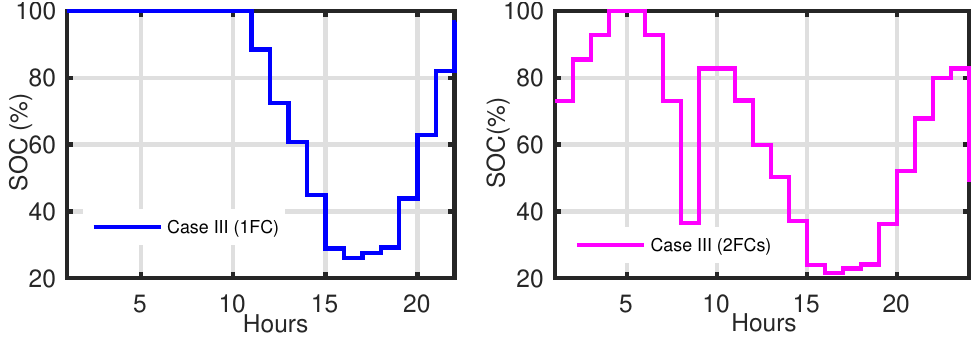
Figure 7. Hourly (%) of SOC for ( a ) I BESS of FC, and ( b ) II BESS of FC for Case III.